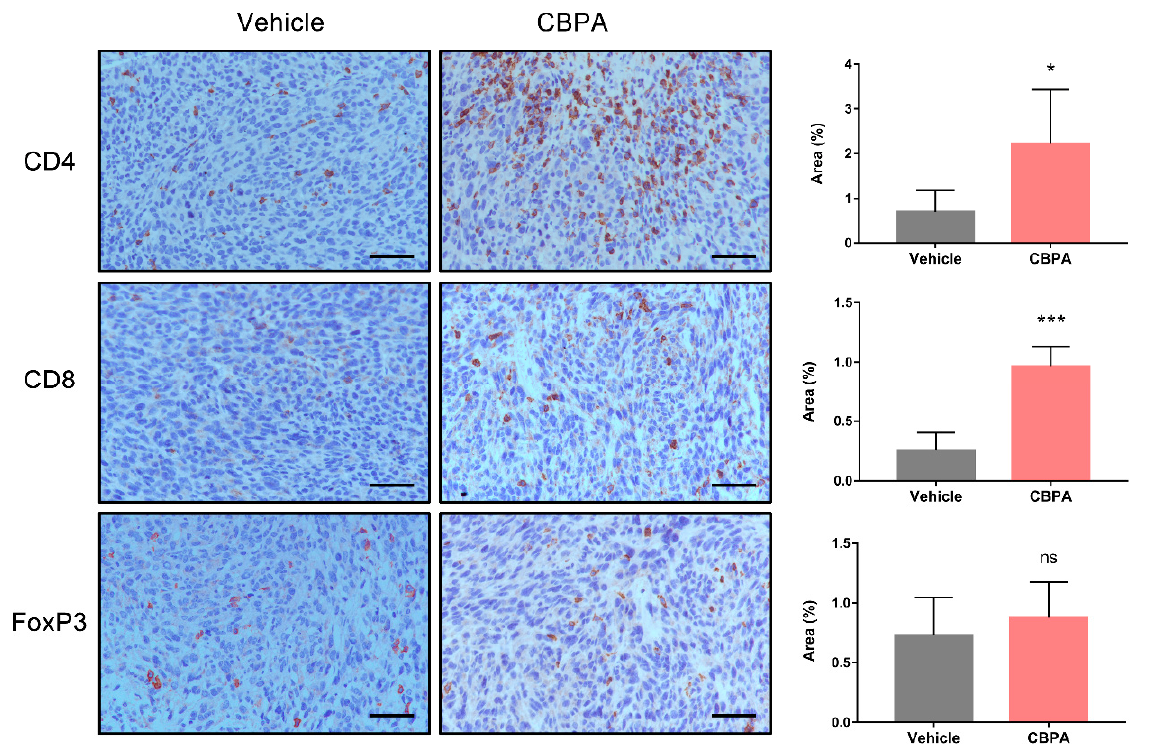
Figure 9. Immunohistochemical analysis of CD4, CD8, and FoxP3 expression in tumor tissues isolated from CBPA- (10 mg/kg) and vehicle-treated MC38 tumor-bearing mice. Scale bars = 100 µ m, × 200. Immunohistochemical quantification (n = 4) was undertaken using Image J. Data are shown as means ± SEM, * p < 0.05; *** p < 0.001; ns, not significant, unpaired t -test.